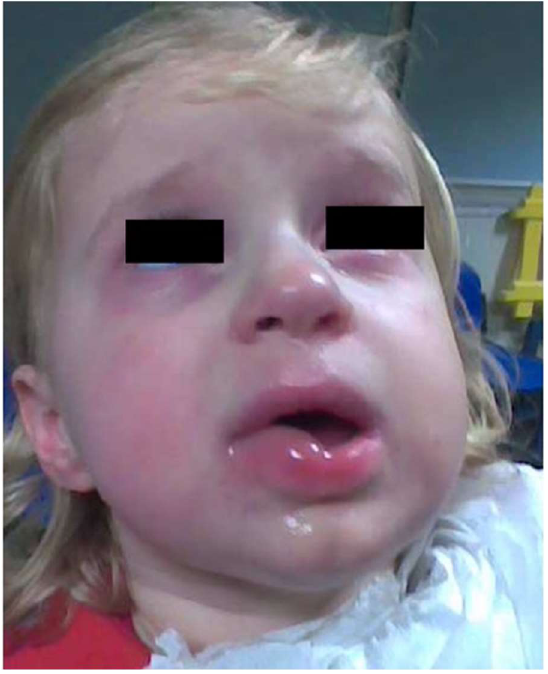
Figure 2. Mucocutaneous reaction during OFC.